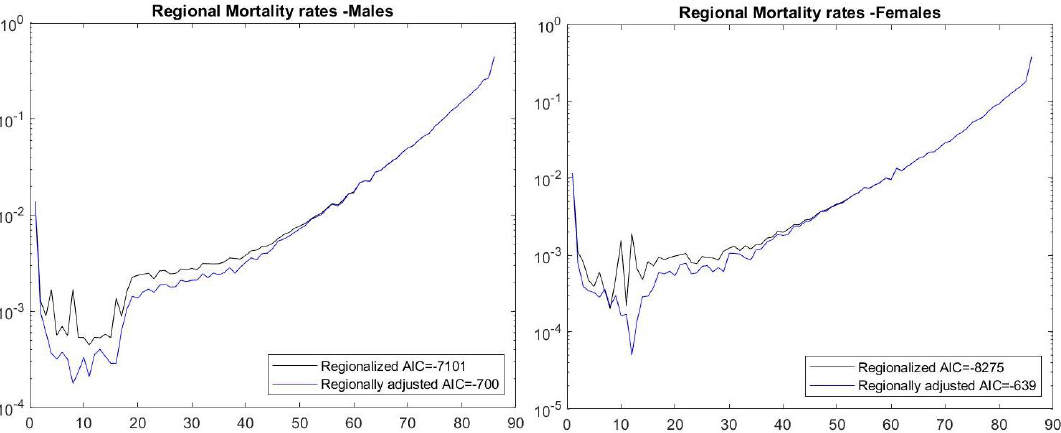
Figure 3. Regionalized mortality rates = by age.